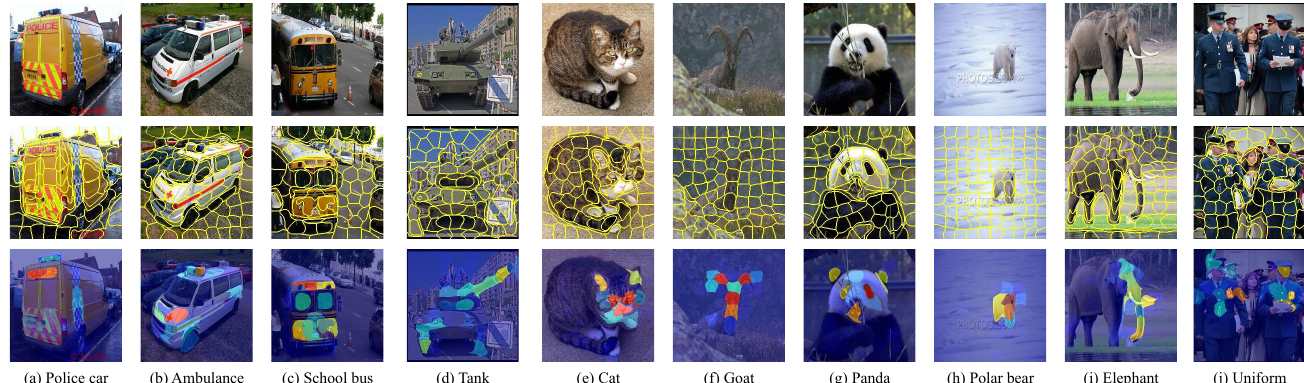
Figure 9. Examples of ground truth result of the relevant feature block marked by the user of each category. ( TOP ) The 10 input image samples in 10 categories from the evaluation data set DataS. ( Middle ) Segmented image with 100 feature blocks obtained according to the SLIC segmentation algorithm. ( Bottom ) Resulting multi-participants human attention mask. Each image is annotated by 40 unique participants.